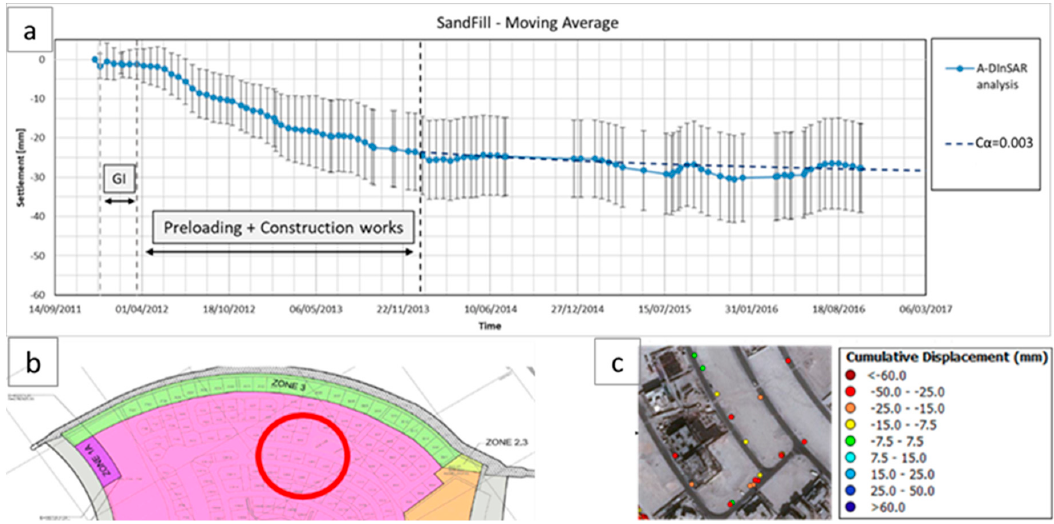
Figure 21. Results integration in the sand fill area including the A-DInSAR time series of displacement in light blue, Settle 3D back analysis dashed line in blue, overlaying the construction stages ( a ). At the bottom, the location ( b ) and the used MPs for the A-DInSAR analyses are shown ( c ).